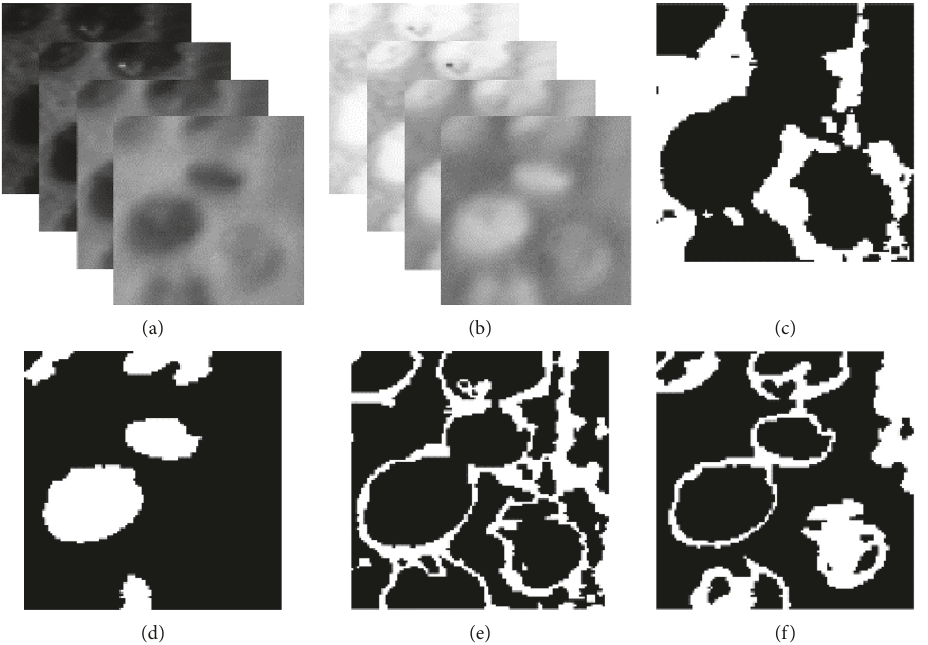
Figure 5: Spatial clustering results with spectral information and K -means algorithm: (a) image cube with selected 10 bands; (b) the complement image cube; (c–f) the classified 4